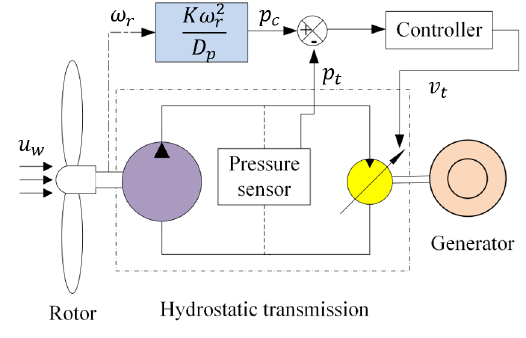
Figure 3. Schematic of the HST wind turbine